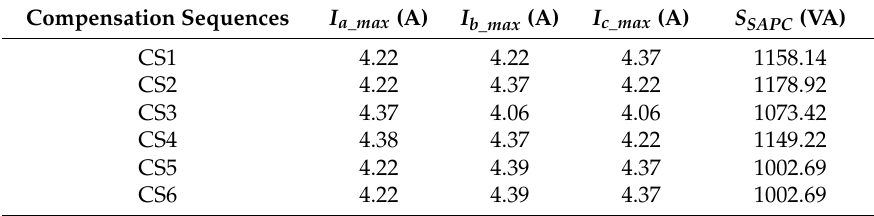
Table 6. SAPC maximum current and SAPC output apparent